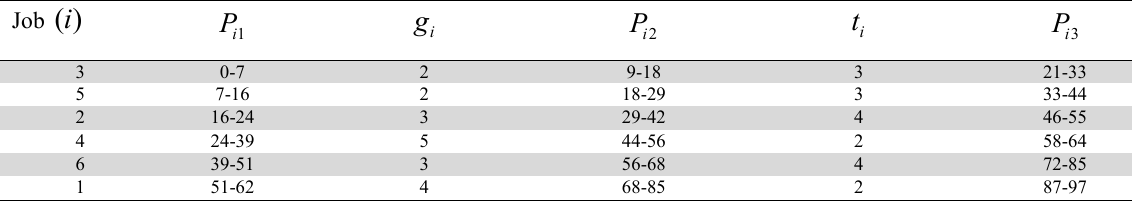
Total elapsed time due to effect of PM times